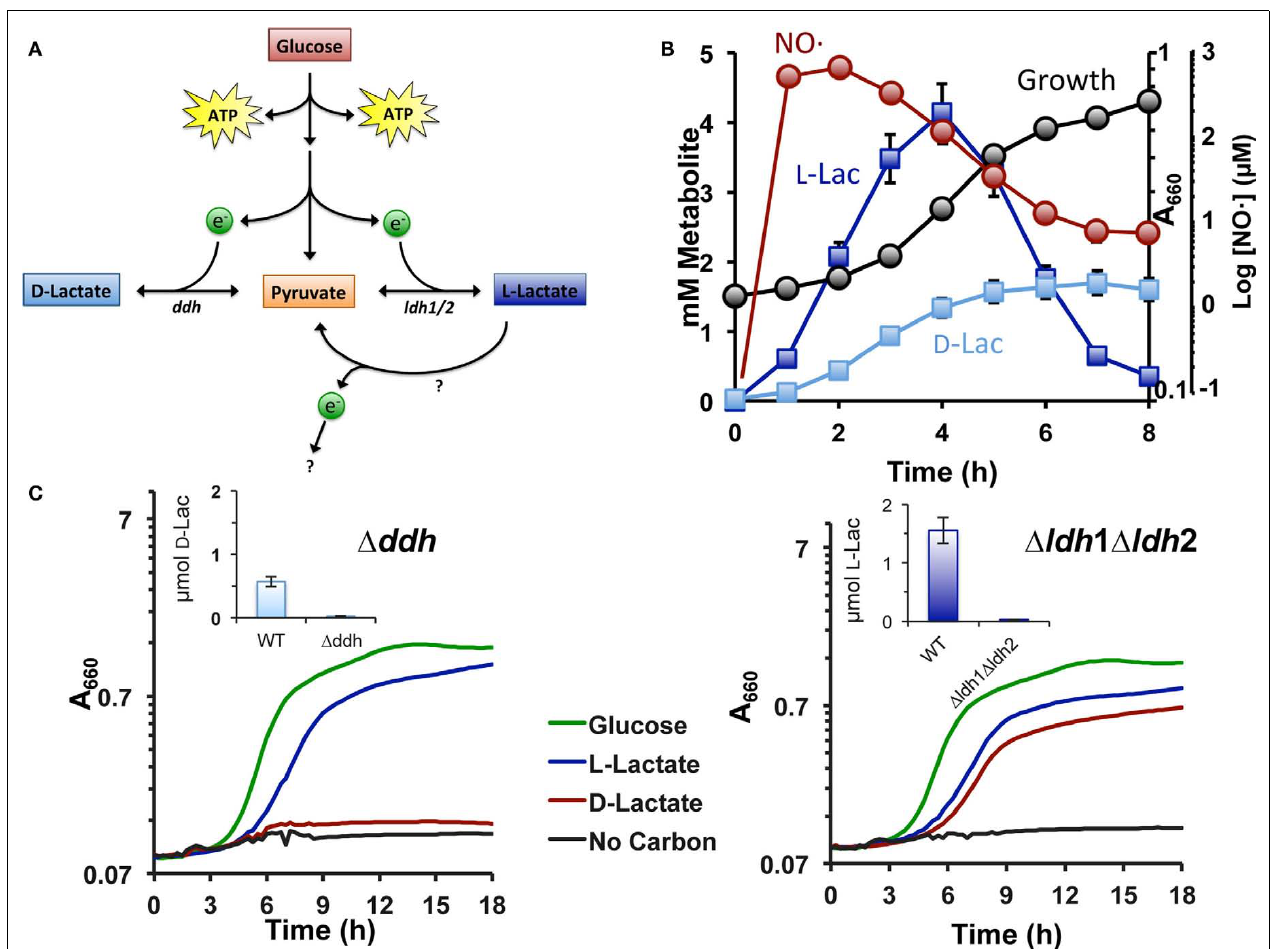
1.5h at ∼ 1mM. (C) Δ ddh mutants (LEFT) no longer excrete D-lactate anaerobically (inset) and specifically lack the ability to grow on D-lactate as a primary carbon source. In contrast, while Δ ldh 1 Δ ldh 2 mutants (RIGHT) do not produce measurable L-lactate anaerobically (inset), the double mutant is still able to utilize L-lactate as a primary carbon source. Residual growth on medium components was subtracted from depicted growth curves (see Materials and